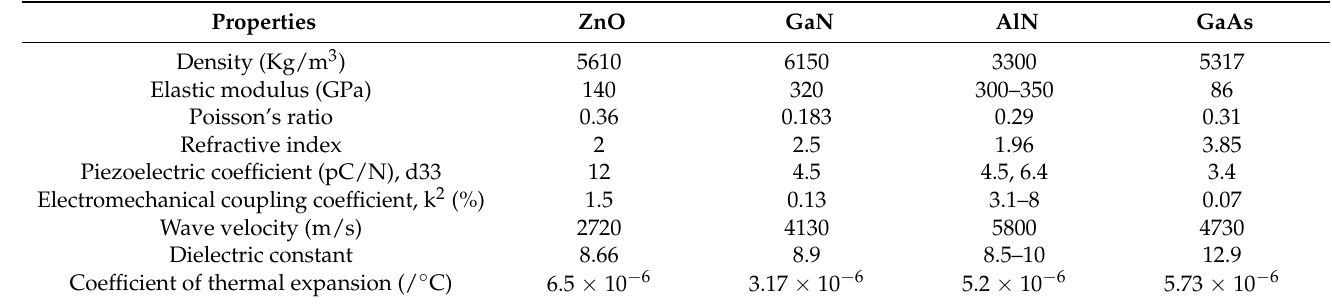
Table 4. Description of different deposited piezoelectrical material